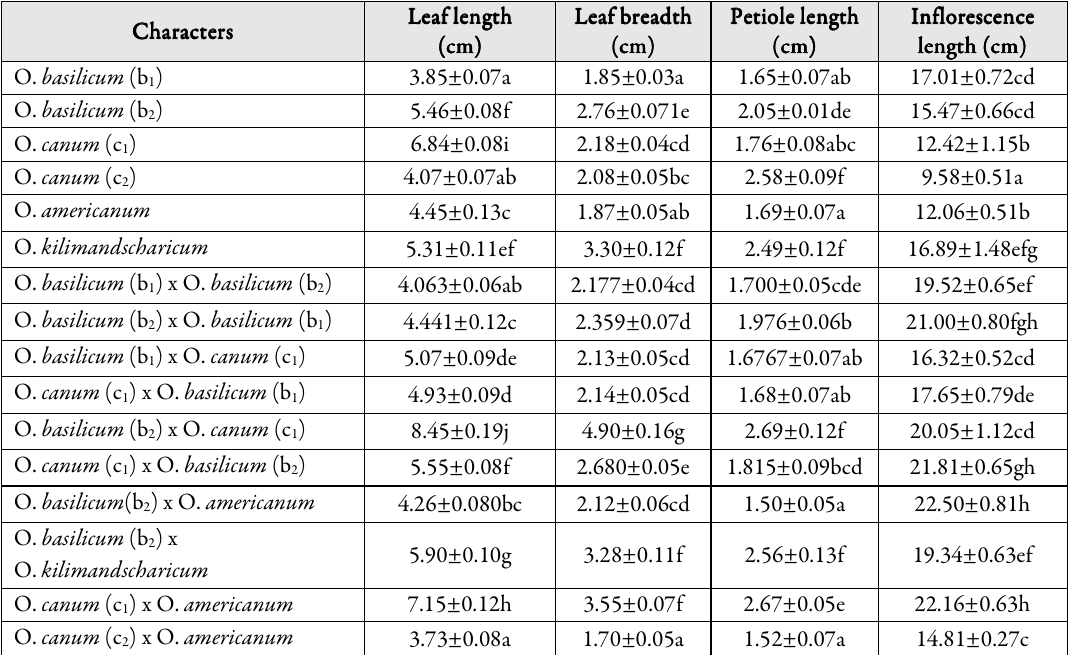
Table 2. Quantitative characteristics of Ocimum spp. and their F 1 hybrids